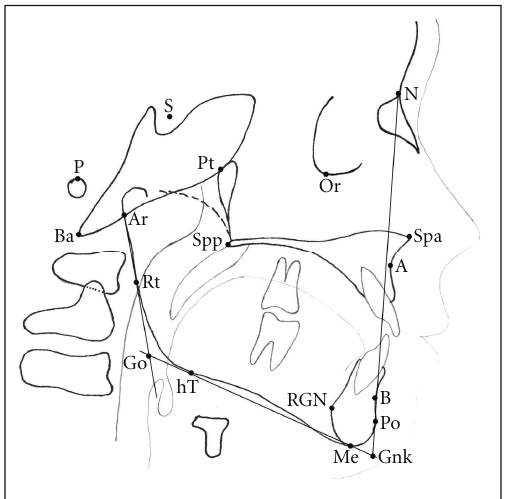
Figure 1: Cephalometric landmarks of the facial skeleton and skull base. (N: nasion, Or: orbitale, S: sella, P: porion, Ba: basion, Ar: arti- culare, Pt: pterygoid, Spp: posterior nasal spine, Spa: anterior nasal spine, A: subnasal/A-point, B: submentale/B-point, Po: pogonion, Gnk: gnathion, Me: menton, RGN: retrognathia, hT: horizontal mandibular tangential point, Rt: vertical ramus tangential point, Go: gonion).